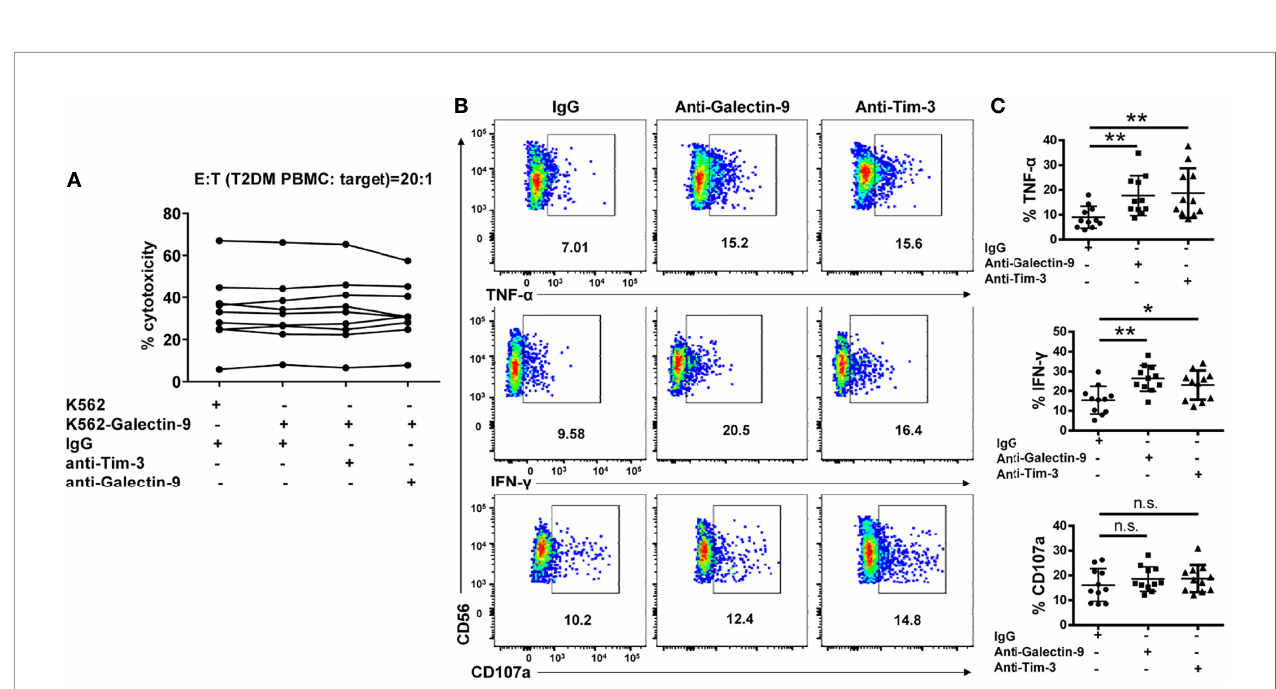
FIGURE 7 | Galectin-9/Tim-3 pathway blockade restores cytokine production in NK cells from T2DM patients but do not affect T2DM NK mediated cell cytotoxicity. (A) PBMCs from T2DM patients were subjected to 4h cytotoxicity assay against K562 and K562-Galectin-9 cells in the presence or absence of Tim-3 and Galectin-9 antibodies. (B) PBMCs from T2DM patients were pretreated with Tim-3 or galectin-9 neutralizing antibodies and stimulated with IL12 and IL18 for evaluating cytokine secretion and granule release. Representative fl ow cytometry plots. (C) Quanti fi cation data. *P < 0.05, **P < 0.01, n.s., not signi fi